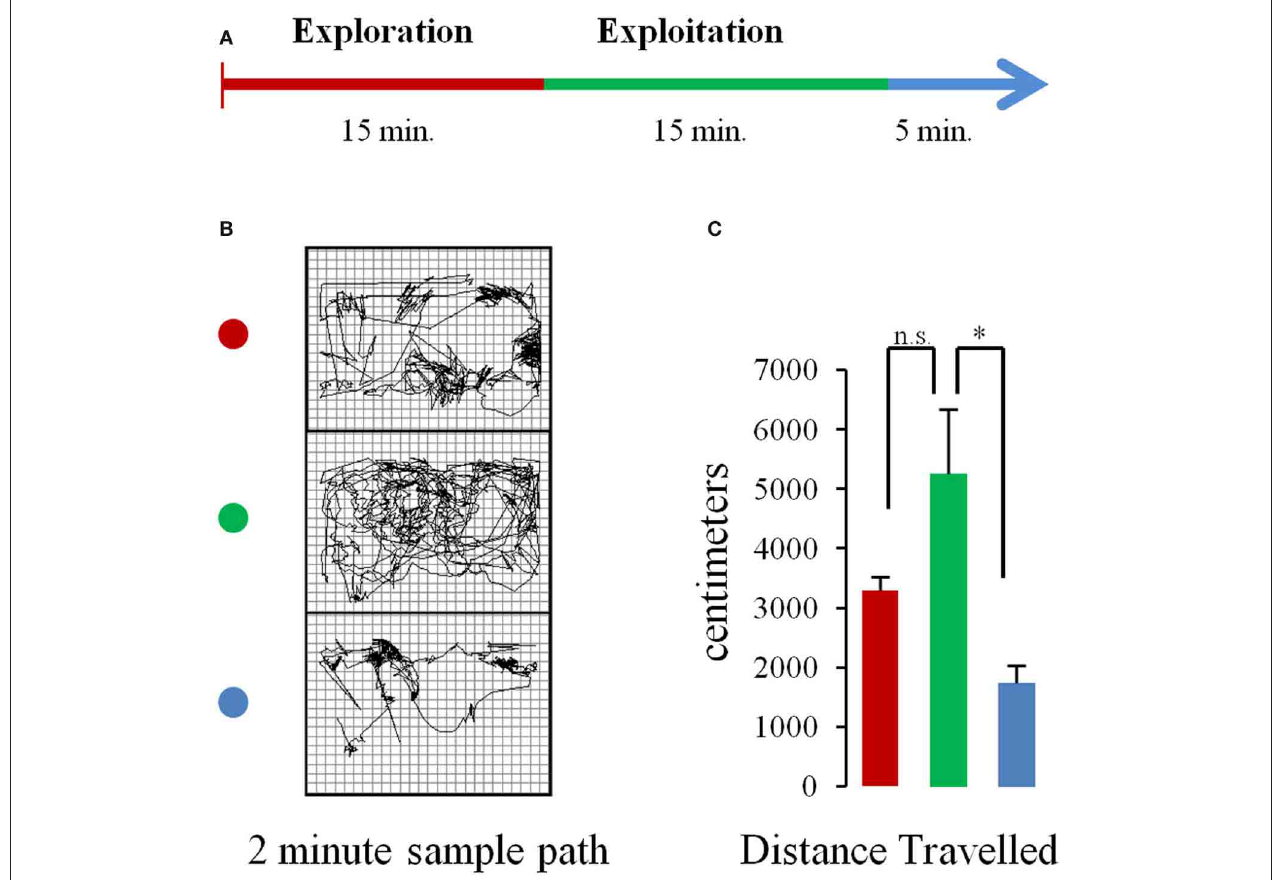
dot, middle), and the post-pellet drop period (blue dot, bottom). (C) Mean (and s.e.m.) distance traveled for animals across sessions during the first 5min of the baseline (red bar), pellet drop (green bar), and post-pellet drop period (blue bar). The rats tended to travel more during the pellet drop period than the baseline period although this failed to reach statistical significance. [ p < 0 . 05( ∗ ); not significant (n.s.)].